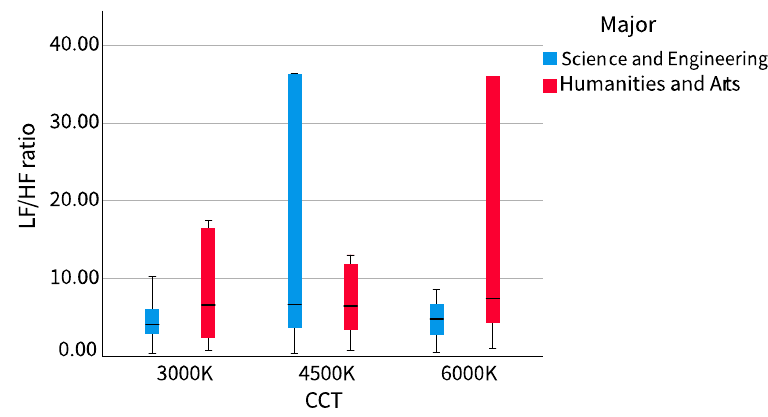
Figure 6. LF/HF ratio line chart (sex).